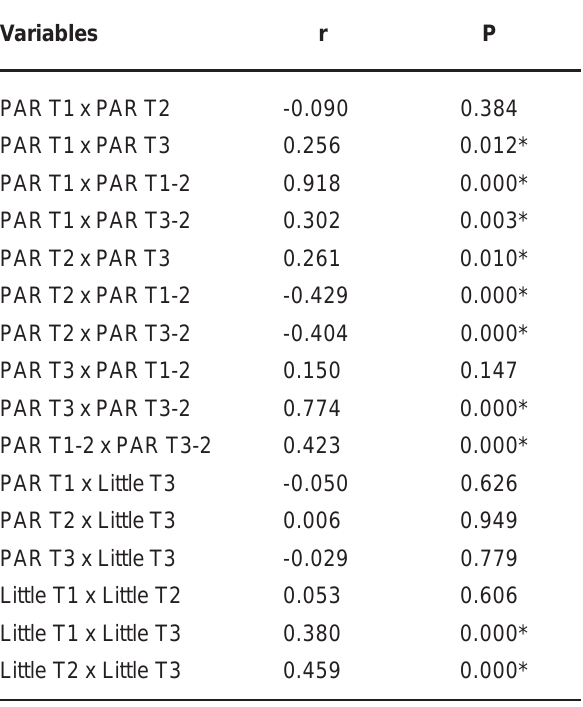
* Statistically significant for